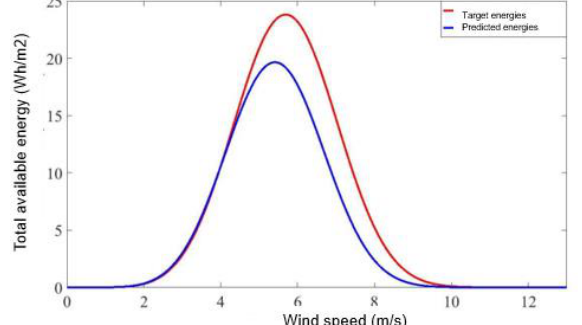
Figure 9. Target and predicted energy curves at 10m